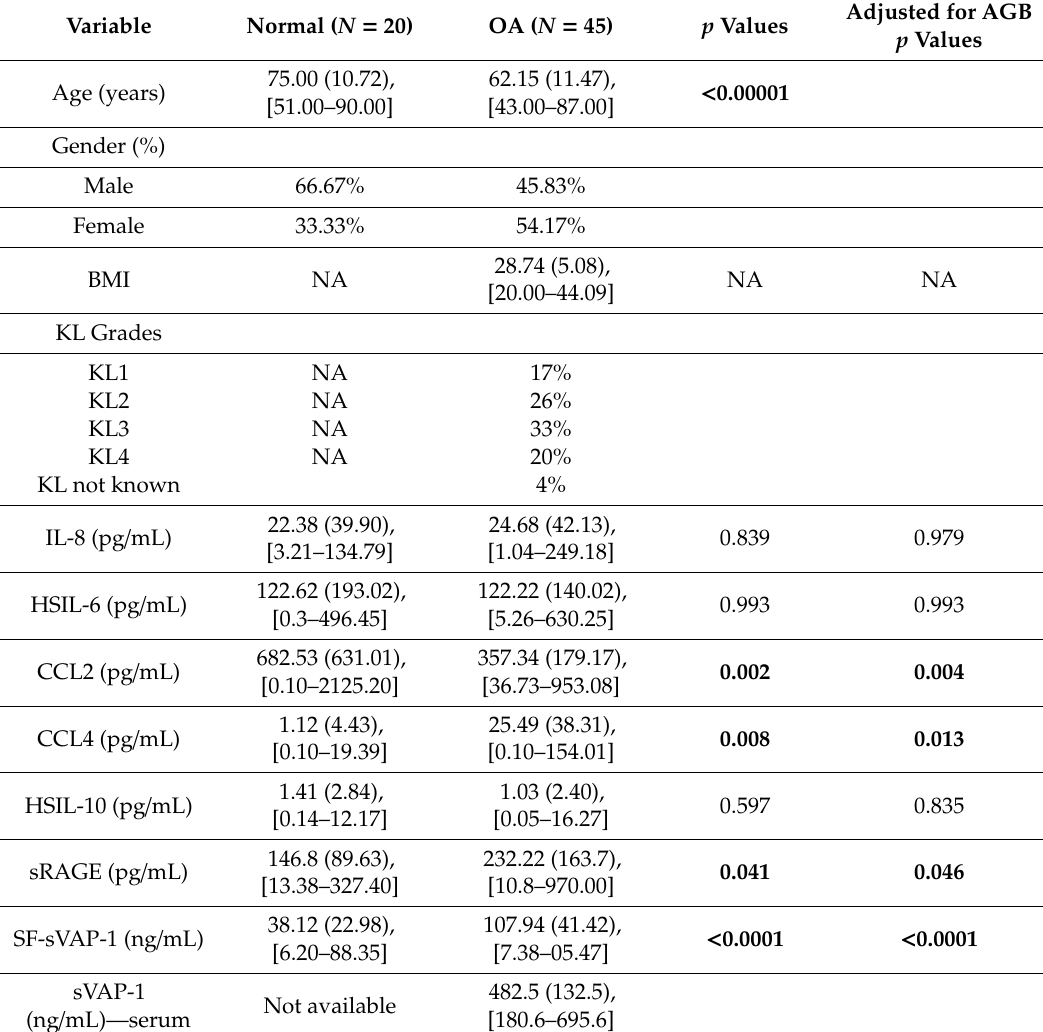
Table 3. Baseline demographics and biomarker levels of synovial fluid